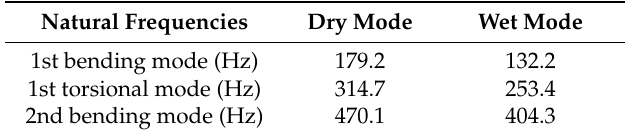
Table 3. Natural frequencies calculated by FEA.